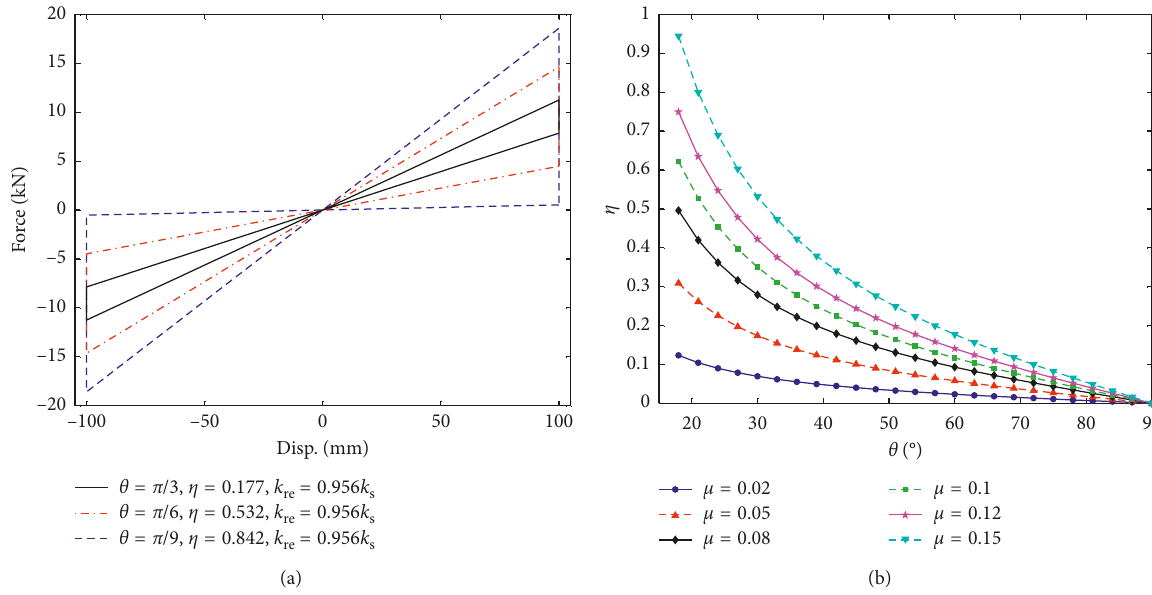
Figure 4: Hysteretic loop and parameter relationship of passive variable friction dampers: (a) damper theory hysteretic loop; (b) variation in the energy dissipation coefficient η with θ .